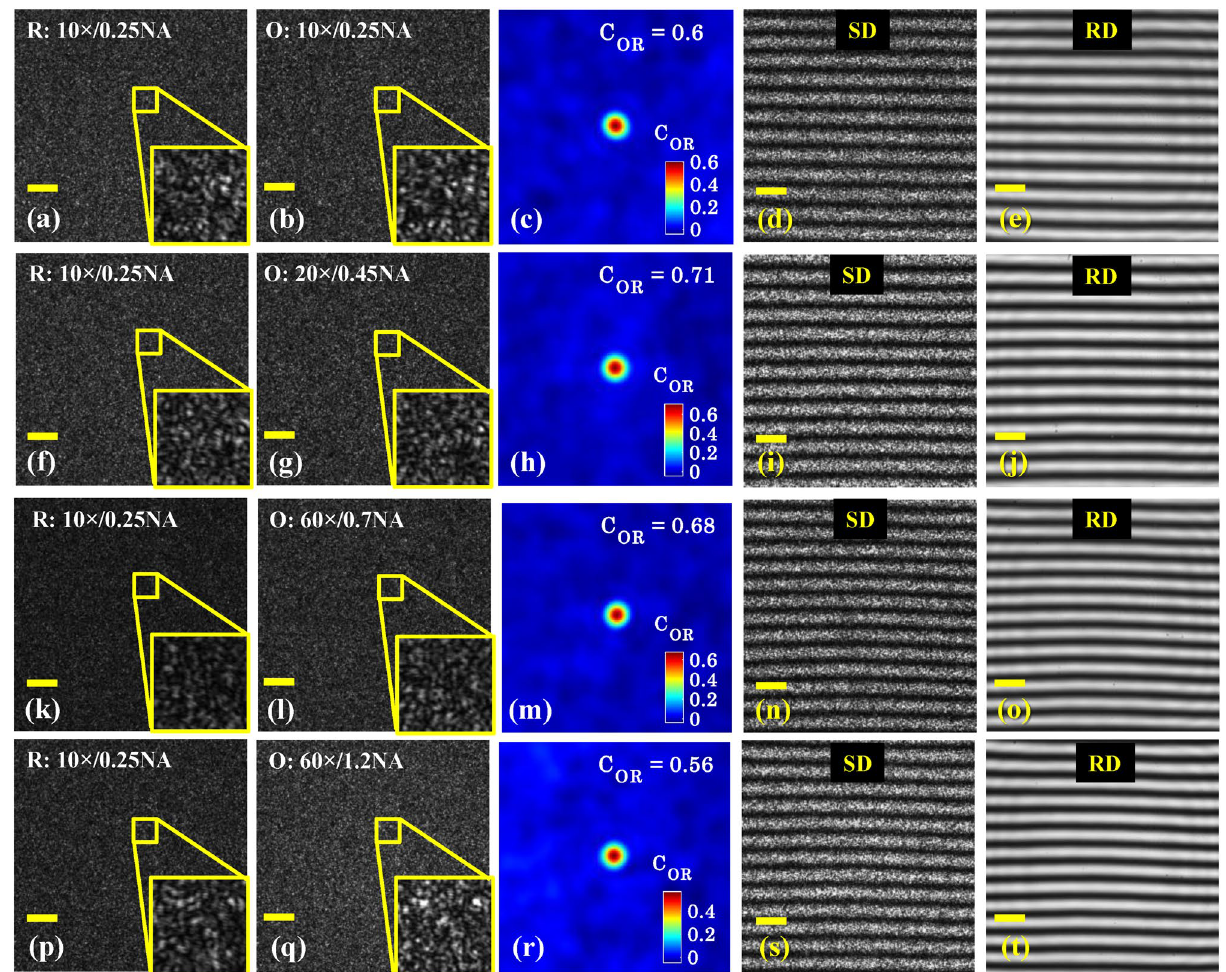
Figure 5. Correlation between the object and reference speckle fields as a function of magnification and numerical aperture. Four different objective lenses 10 ×/0.25NA, 20 ×/0.45NA, 60 ×/0.7NA and 60 ×/1.2NA are sequentially inserted in the object arm keeping fixed reference arm objective lens 10 ×/0.25NA. ( a , f , k , p ) and ( b , g , l , q ) The reference and the object arm speckle fields corresponding to fixed reference objective lens and all four objective lenses in the object arm, respectively. ( c , h , m , r ) illustrate the 2D normalized correlation map between both the speckle fields. In all correlation maps, only 128 × 128 central pixels are considered to clearly demonstrate the correlation peak. ( d , i , n , s ) Superpositions of the object and the reference arm speckle fields also called specklogram corresponding to all four objective lenses in the object arm. The diffuser is kept stationary. ( e , j , o , t ) The temporally averaged patterns of a large numbers of specklograms within the exposure time of the camera. This is achieved by rotating the diffuser at an adequate speed. The scale bars are represented in solid yellow color horizontal lines. Scale bar: 300